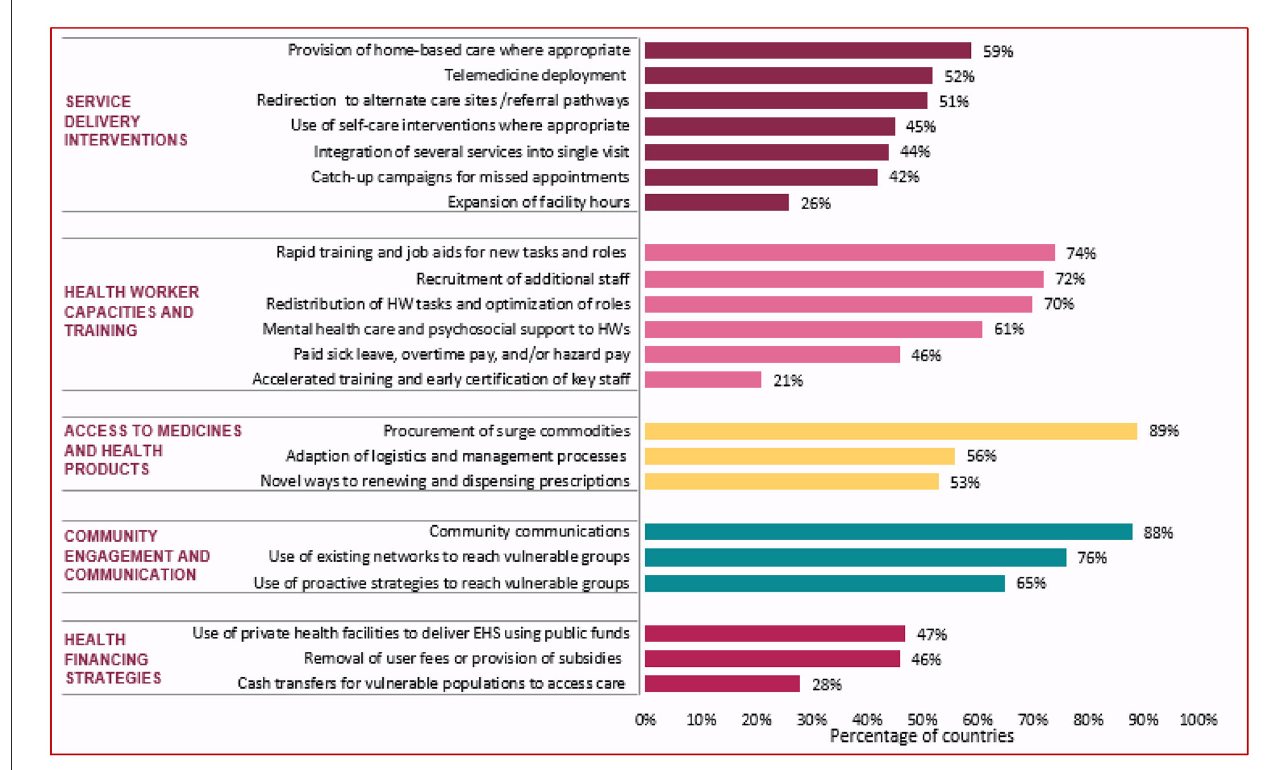
FIGURE3 Percentage of countries implementing mitigation and recovery actions, November–December 2021 ( n = 98). Examples of community communications included: communications to inform communities of changes to service delivery in the COVID-19 context communications to address misinformation and community fears of infection, targeted outreach where service utilization had declined, and the establishment of hotlines or community radios. HW, health workers; EHS, essential health